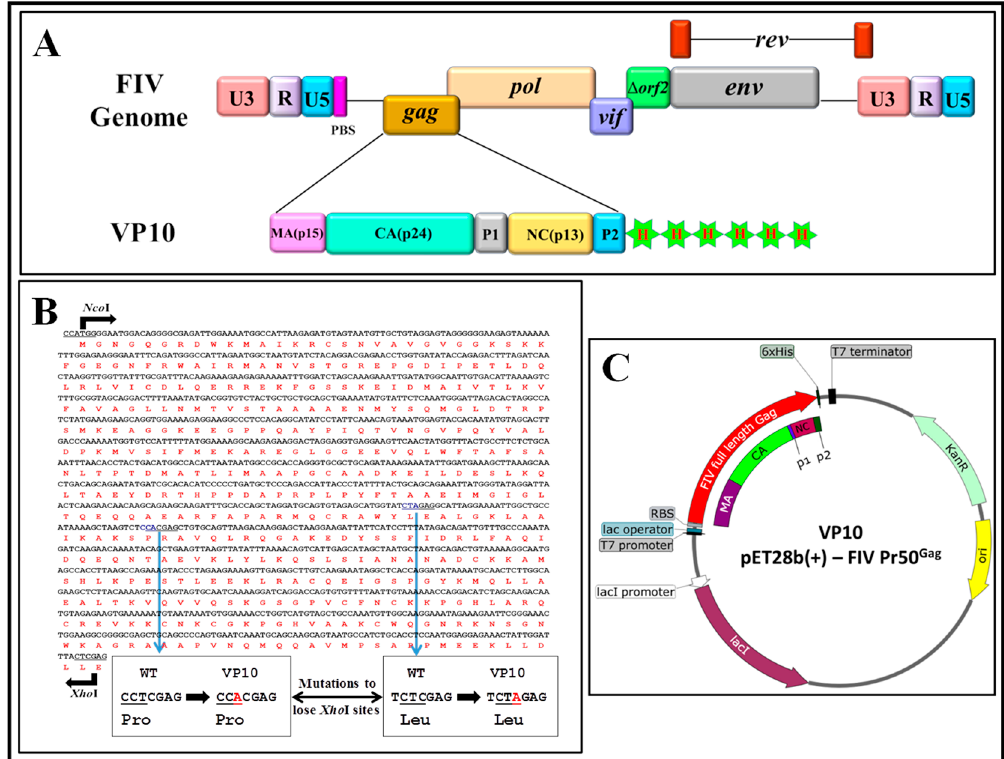
Figure 3. Graphical representation of cloning of the FIV genome and full-length Pr50 Gag -His 6 -tag bacterial expression plasmid. ( A ) Schematic representation of the FIV genome and VP10 FIV full-length Pr50 Gag bacterial expression plasmid showing Gag precursor domains and His 6 -tag. ( B ) FIV full-length Pr50 Gag nucleotide and amino acid sequences with mutations introduced (shown as insets) to lose two Xho I sites for cloning purposes without changing the amino acid sequence. ( C ) Schematic representation of VP10- FIV full-length Pr50 Gag after cloning Gag sequences in the modified pET28b ( + ) vector in which Pr50 Gag is expressed from the bacteriophage T7 promoter.